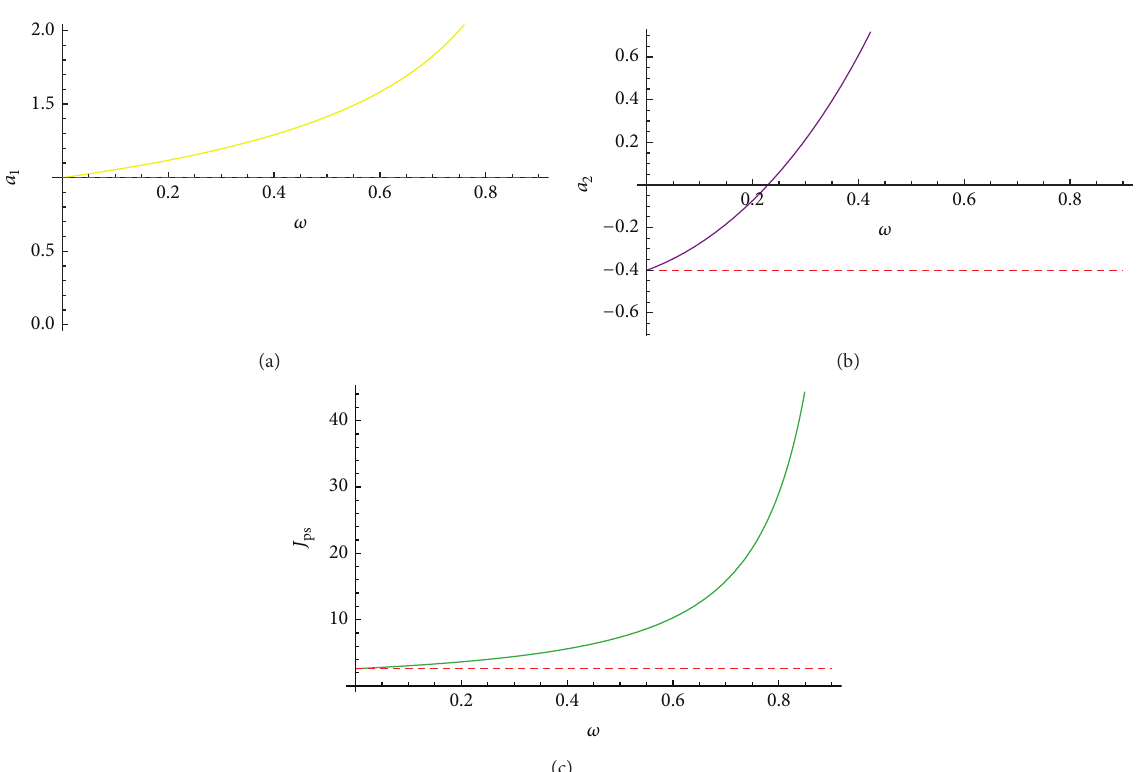
Figure 3: Behavior of strong field deflection coefficients ( 𝑎 1 (a) and 𝑎 2 (b)) and parameter 𝐽 purple, and green while red (dashed) line shows Schwarzschild